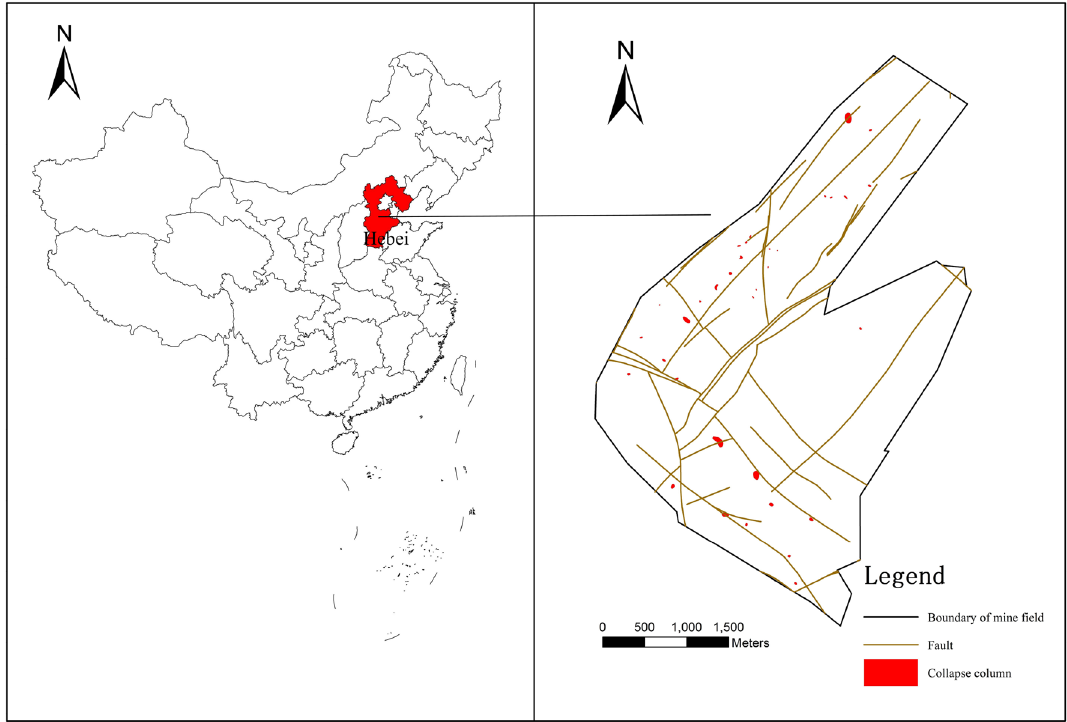
Figure 1. Location and structural geology map, Images are created using the Coreldraw, http:// www. corel draw. com/ en/? link=